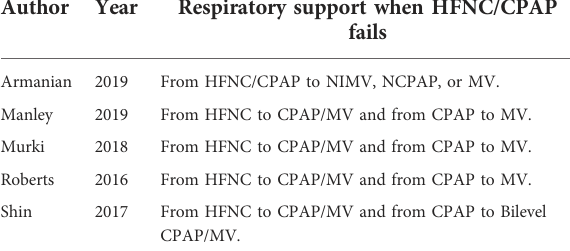
TABLE 2 Alternative non-invasive respiratory support was used as a remedy for treatment